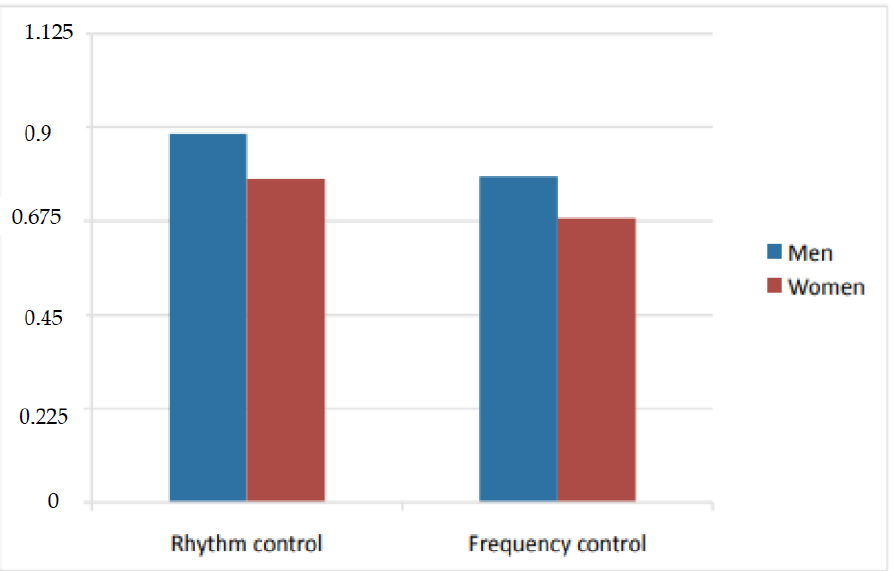
Figure 1. Mean EQ-5D score in men and women according to the treatment strategy used (rhythm control versus frequency control).